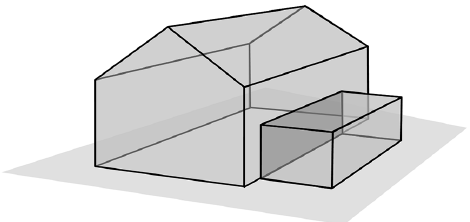
Figure 3. Vertical common wall between two connected buildings.